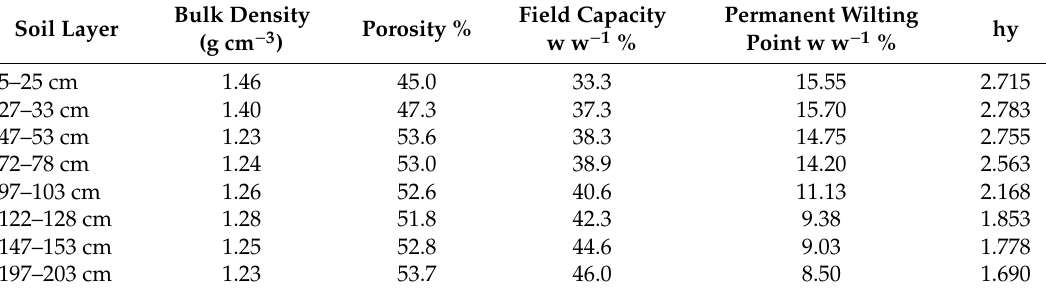
hy: hygroscopicity according to